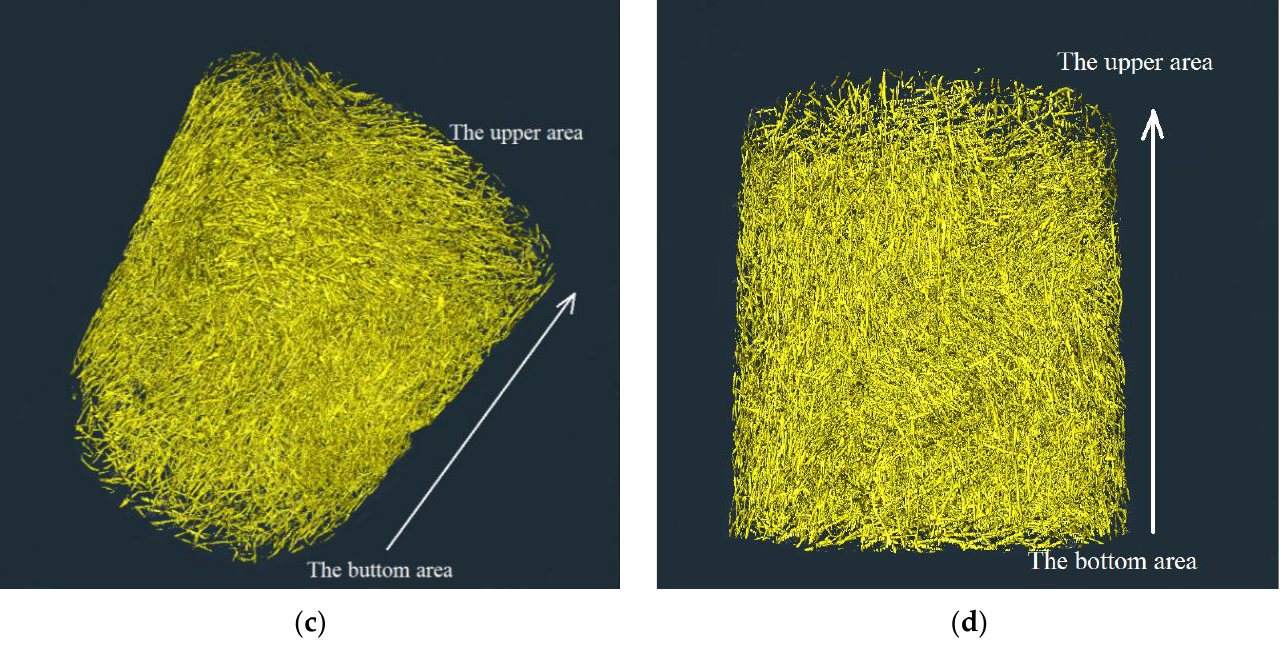
Figure 14. The fiber structures of SSUHPC and FRUHPC: ( a ) SSUHPC, vertical view; ( b ) SSUHPC, side elevation; ( c ) FRUHPC, vertical view; ( d ) FRUHPC, side elevation.